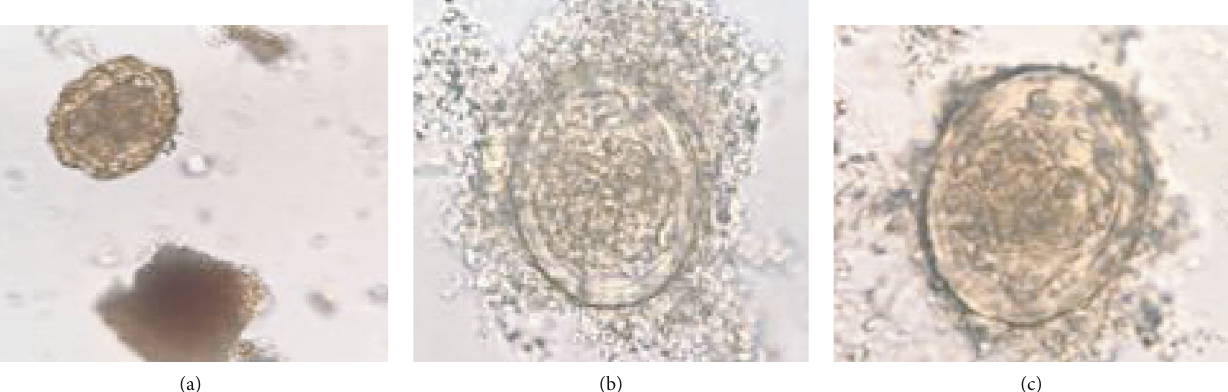
Figure 8: The 3 wrong predictions. (a) Fertile type, but predicted as infertile type. (b, c) Images of a decorticate type but predicted a